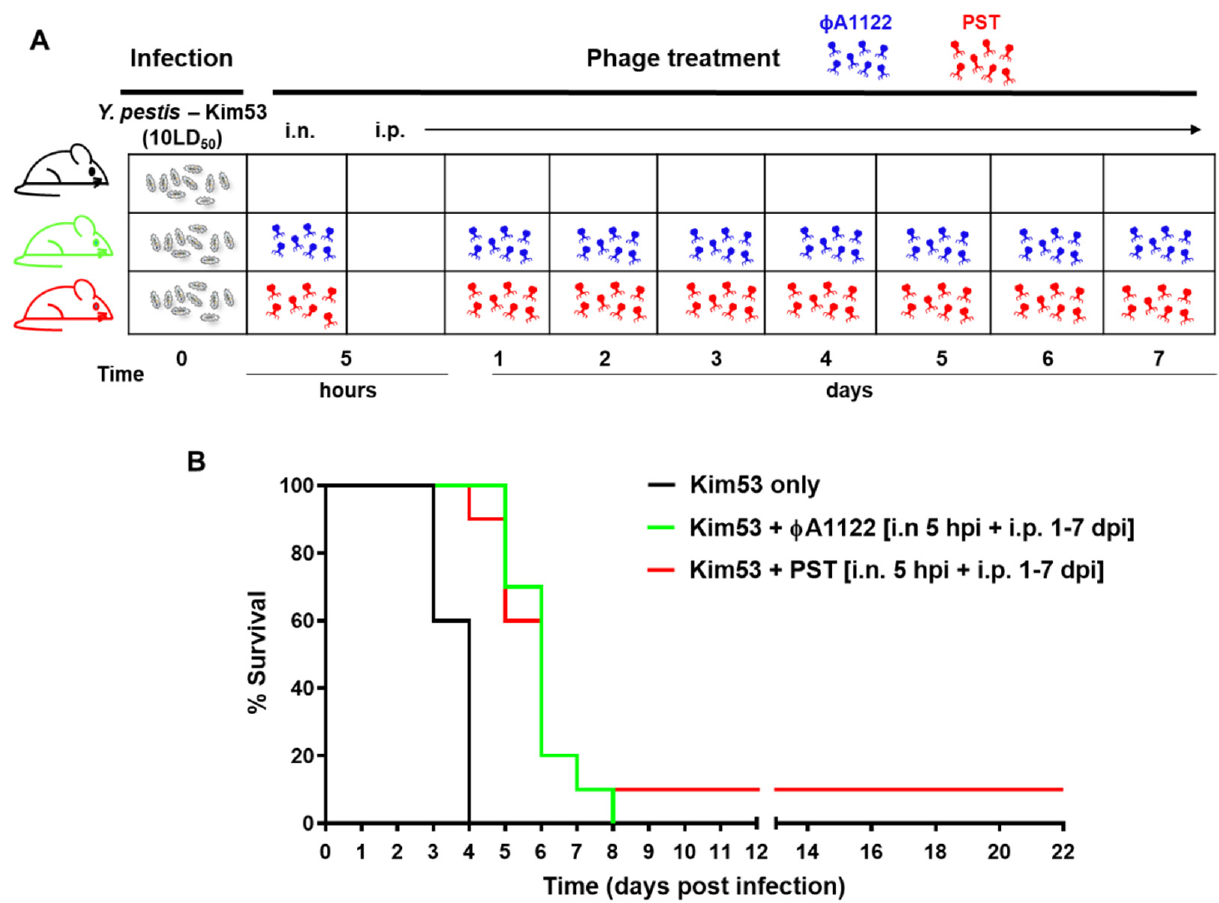
Figure 6. Treatment of pneumonic plague with ф A1122 or PST results in similar outcomes. ( A ) Schematic presentation of the phage treatment regimen. C57BL/6J mice were IN infected with 10 × LD 50 Y. pestis Kim53 (gray symbols), followed by PBS (control group) or phage administration. Each dose of PST (red phage symbol) or ф A1122 (blue phage symbol) suspension contained 1 × 10 9 phages. ( B ) Survival curves. The mouse groups were as follows: no phage (n = 5, black line), IN phage administration at 5 hpi followed by IP injections every 24 h on days 1–7 post bacterial infection (n = 10; green line for ф A1122 and red line for